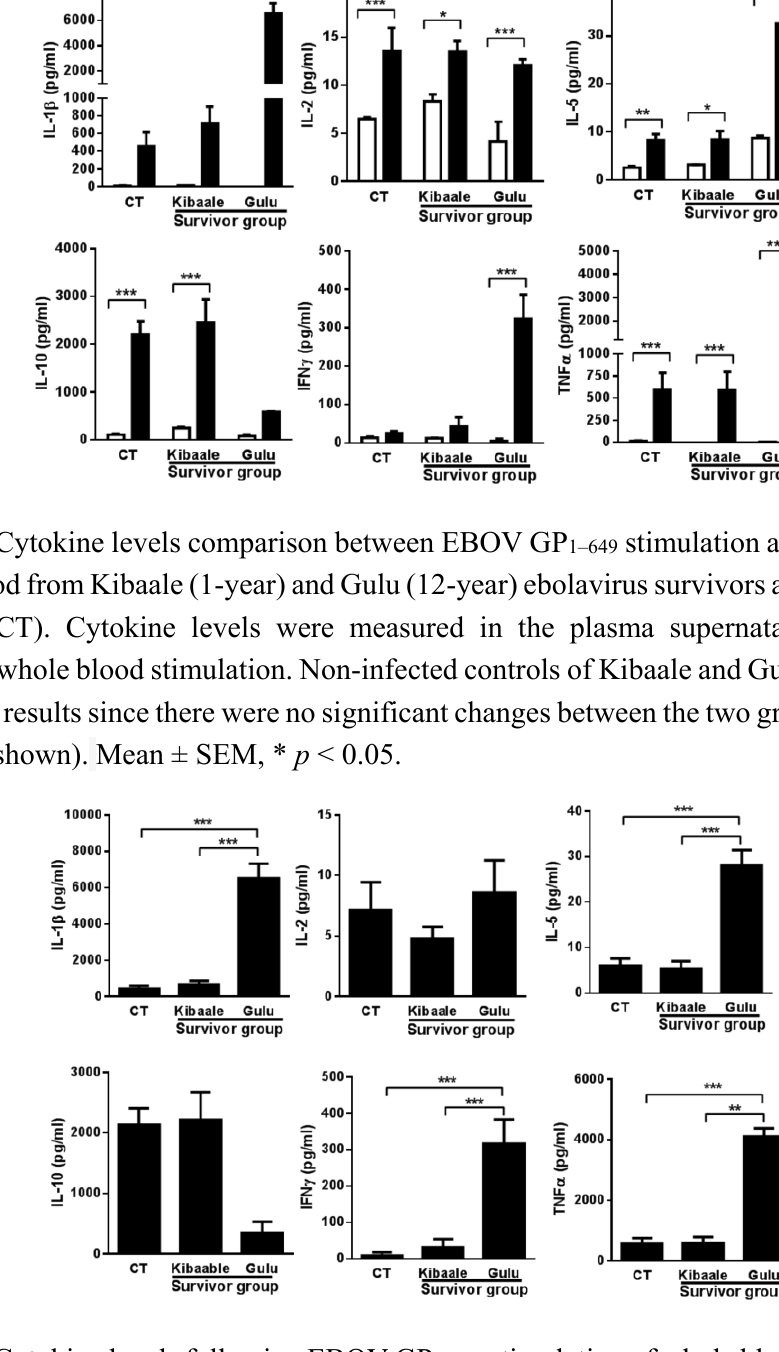
Figure 4. Cytokine levels following EBOV GP 1–649 stimulation of whole blood from Kibaale (1-year) and Gulu (12-year) ebolavirus survivors and non-infected controls (CT). Cytokine levels were measured in the plasma supernatants of samples following whole blood stimulation. Normalization of cytokine expression levels was performed by reducing the background (unstimulated value) of each individual stimulated (EBOV GP 1–649 ) sample. Non-infected controls of Kibaale and Gulu are presented as average results since there were no significant changes between the two groups (Data not shown). Mean ± SEM, * p <